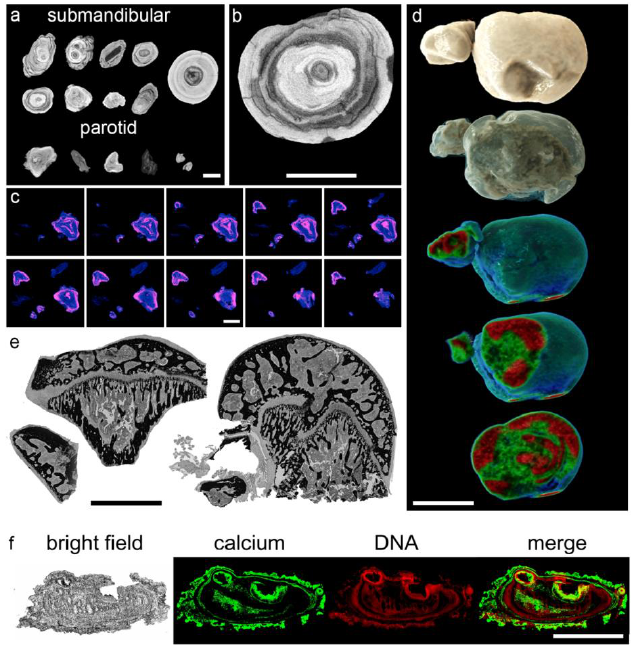
Figure 2. Sialoliths show onion skin-like layers, indicating a discontinuous formation process. ( a ) Micro-computed tomography (Micro-CT) images reveal concentric layers of calcifications (bright) around the center of submandibular ( n = 9) and parotid sialoliths ( n = 5), alternating with more radiotranslucent (dark) areas. ( b ) Magnification of a micro-CT image of a submandibular sialolith shown in ( a ). ( c ) Follow-up sections of artificially stained complete parotid sialoliths ( n = 5; blue and pink reflect X-ray translucent and radiodense areas, respectively). ( d ) Representative 3D CT scan reconstructions of a submandibular sialolith ( n = 5). Houndsfield units reflecting the radiodensity are represented by color codes (green reflects X-ray translucent and red reflects radiodense areas, respectively). ( e ) Representative Von-Kossa staining of methacrylate sections of submandibular sialoliths ( n = 9) revealed that mineralized, predominantly calcium-containing areas (black) surround regions of organic depositions (gray). The observed onion skin-like layers are partially traversed by small septs, additionally enclosing organic compounds. ( f ) Calcifications (von-Kossa stain, negatively displayed in green) alternate with organic layers that harbor extracellular DNA (stained with propidium iodide, displayed in red), which are representatively shown in a submandibular sialolith ( n = 11). Scale bar ( a – f ): 5